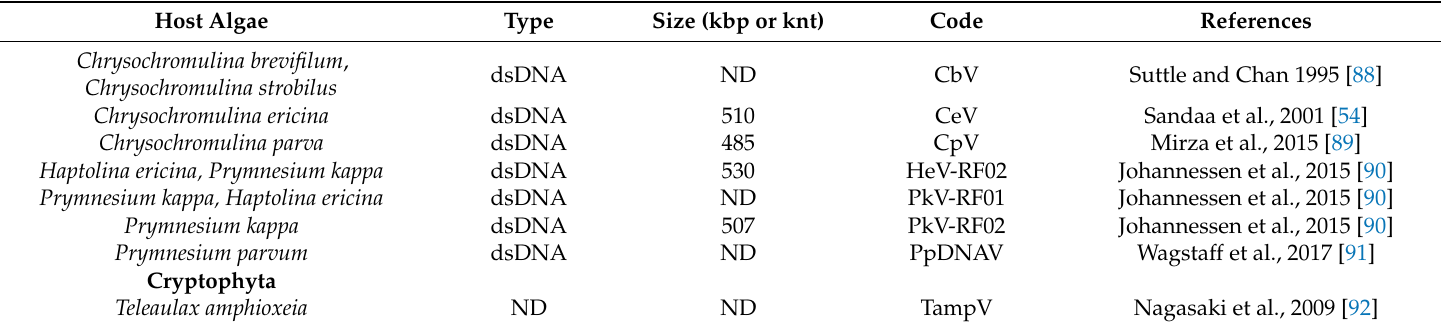
Table 1. Summary of all reported eukaryotic algal viruses that have been isolated. A range of genome sizes (kbp or knt) represents multiple virus strains associated with the same host species, and in this case, only the type virus is reported under the code column. Asteriks denote original names for some of the diatom ssDNA viruses, which have since been renamed and placed into genera of the family Bacilladnaviridae ( Chaetoceros setoensis DNA virus = Diatodnavirus ; Chaetoceros salsugineum DNA virus 1 = Chaetoceros protobacilladnavirus 1; Chaetoceros sp. DNA virus 7 = Chaetoceros protobacilladnavirus 2; Chaetoceros lorenzianus DNA virus = Chaetoceros protobacilladnavirus 3; Chaetoceros tenuissimus DNA viruses type I and II = Chaetoceros protobacilladnavirus 4). ND = Not detected or